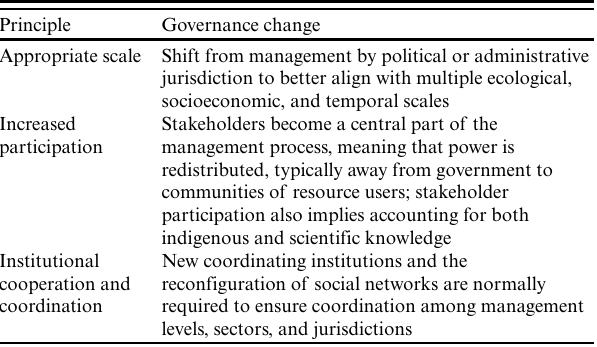
Table 1. Governance changes implied by selected principles of ecosystem-based fisheries managment and ecosystem approach to fisheries management. Adapted from Staples et al. (2014).